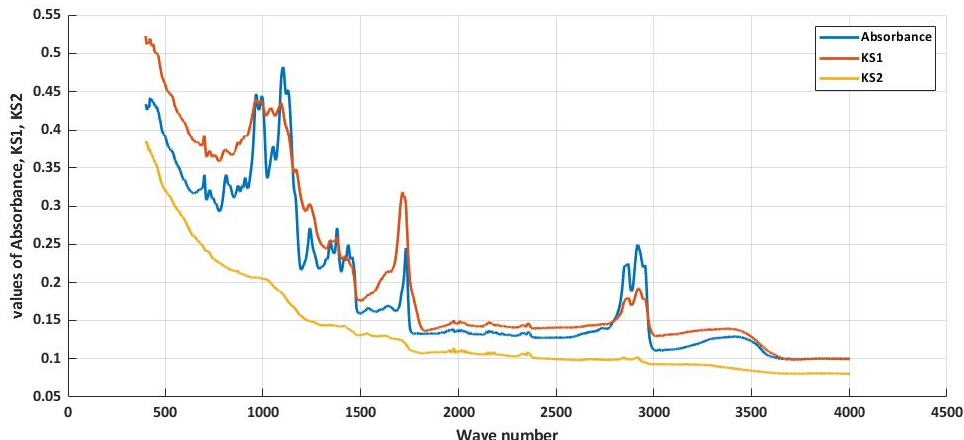
Figure 4. Results for VO_50_PVB_50_TF [authors’ own processing].